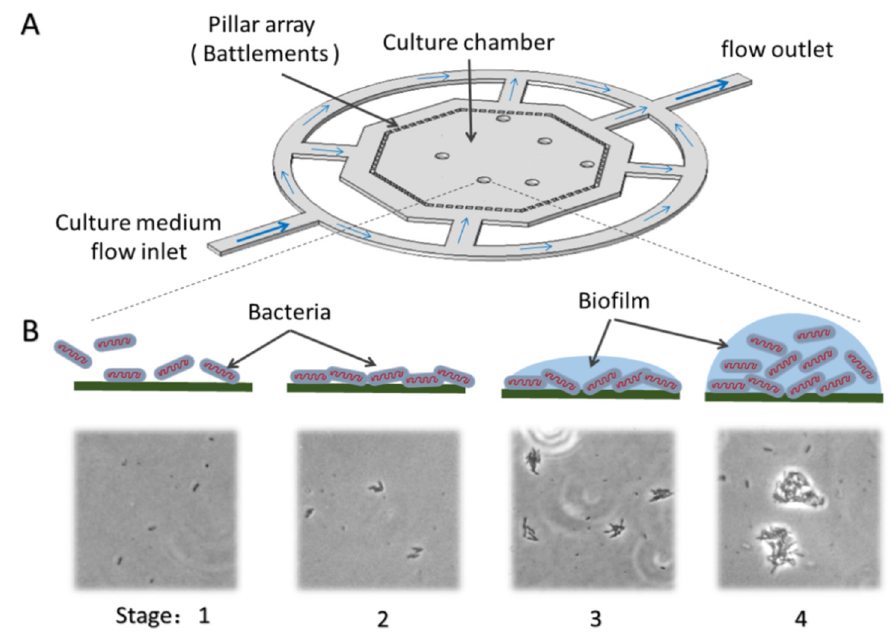
Figure 1. Schematic illustrations of chip structures for bacteria culture and biofilm formation. ( A ) The diameter of inscribed circle of regular octagon area is 2 mm. The size of a single micropillar is 54 µ m × 40 µ m (top view) and the gap between pillars is 30 µ m. The depth of both the channel and the culture chamber is 50 µ m. ( B ) Schematic illustrations and optical images of stages of biofilm development: (1) Loose adhesion to the surface. (2) Irreversible attachment. (3) Bacteria secrete the extracellular polymeric substances (EPS) to form the biofilm structure, and the biofilm matures. (4) Biofilms are completely mature.